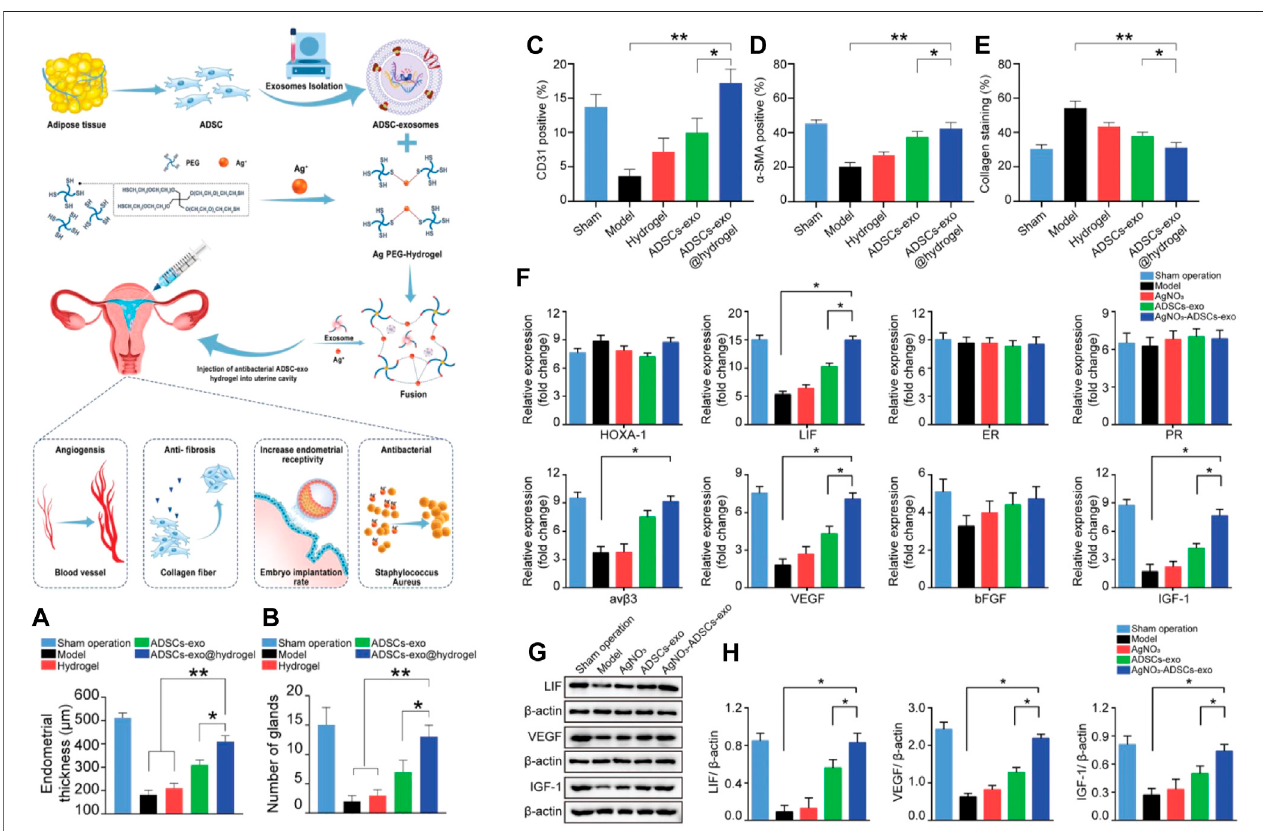
FIGURE 6 | Schematic overview of the development of an ADSC-exo hydrogel for endometrial regeneration. (A) Endometrial thicknesses in each group. (B) Numbers of glands in each group. Administration of ADSC-exos or AgNO3+ADSCs-exo promotes endometrial neovascularization, myometrial regeneration, and reduced endometrial collagen deposition. (C – E) Quanti fi cation of CD31, α -SMA, and collagen protein expression levels. The impact of ADSCs-exo and hydrogel transplantation ontheexpression ofmarkersofendometrialreceptivityand angiogenesis. (F) AqRT-PCRapproachwasusedtoassesstheexpression ofmarkers ofendometrialreceptivity (HOXA-1, LIF,ER, PR,Integrin β 3,IGF-1)and angiogenesis (VEGF, bFGF),with β -actin serving asanormalization control. (G) Westernblotting was used to assess LIF, VEGF, and IGF-1 protein expression in each treatment group. (H) Western blotting data of the levels of LIF, VEGF, and IGF-1 in different treatmentgroups.Dataareshownrelativetointernalreferencecontrols.Dataaremeans±standarderror,n=5.* p < 0.05,** p < 0.01.Reproducedwithpermissionfrom ref (Lin et al., 2021). Copyright 2021 Wiley-VCH GmbH.